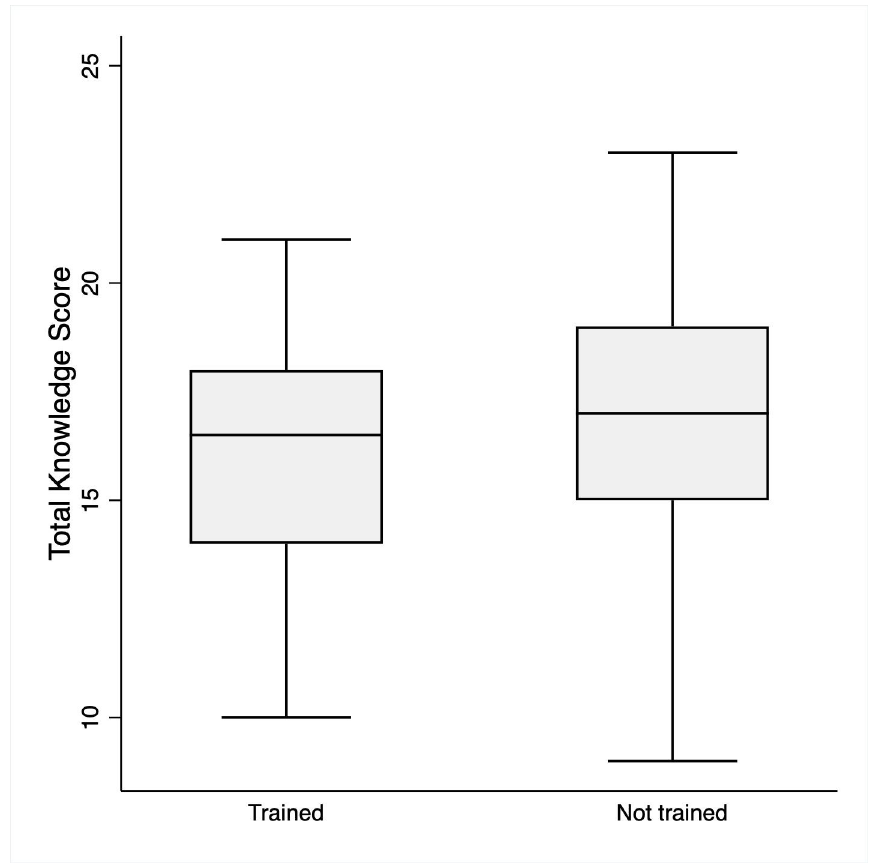
Fig 2. Knowledge scores in trained vs untrained healthcare workers. Mean knowledge scores for trained (16.2 ± 2.5) vs untrained (16.6 ± 2.9) participants at Jimma University Medical Center (p-value